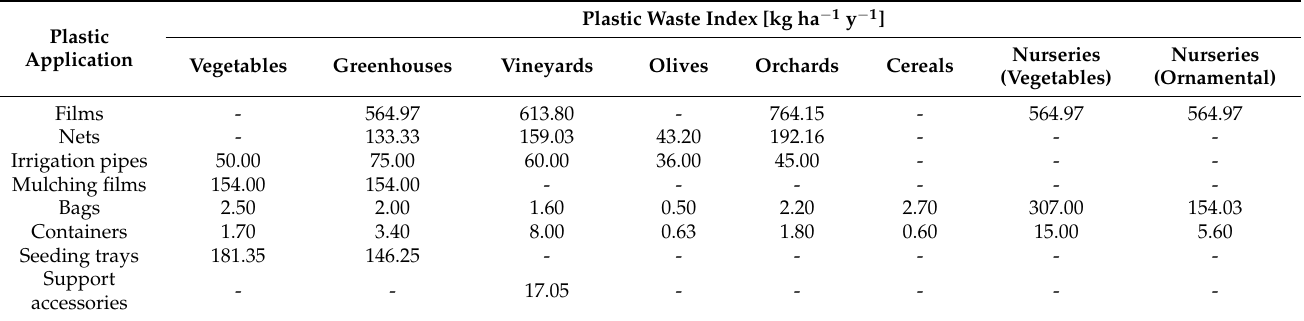
Table 2. Plastic waste index for each plastic application and for each crop